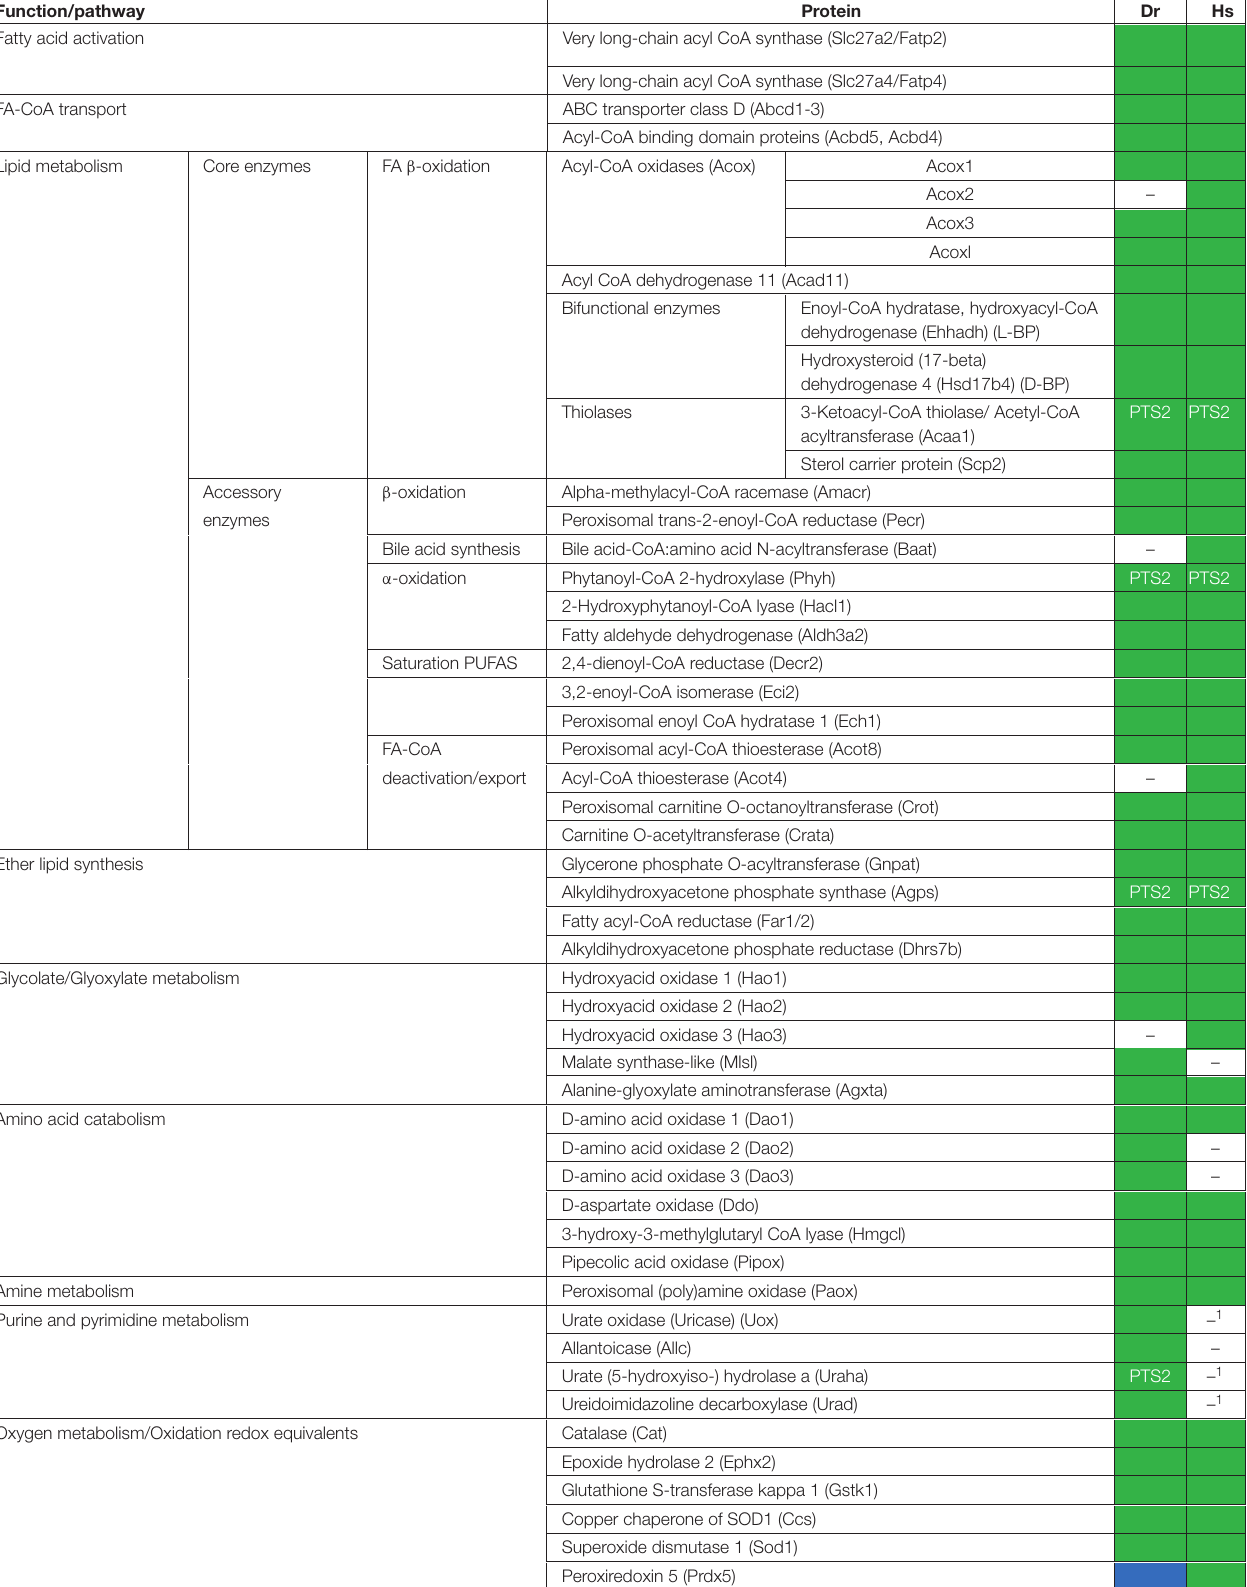
TABLE 1 | Inventory of Danio rerio peroxisomal proteins and metabolic pathways in comparison to H. sapiens